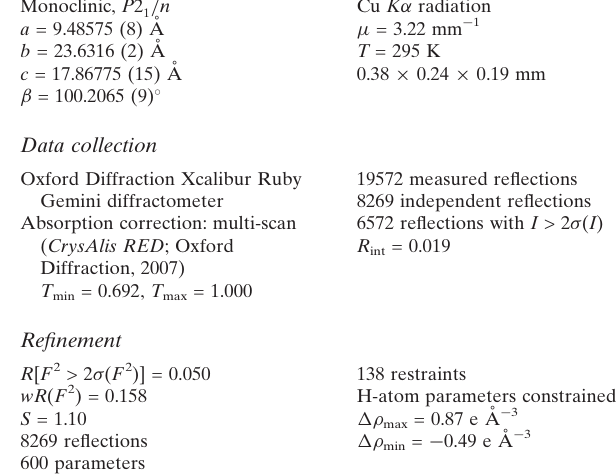
Data collection